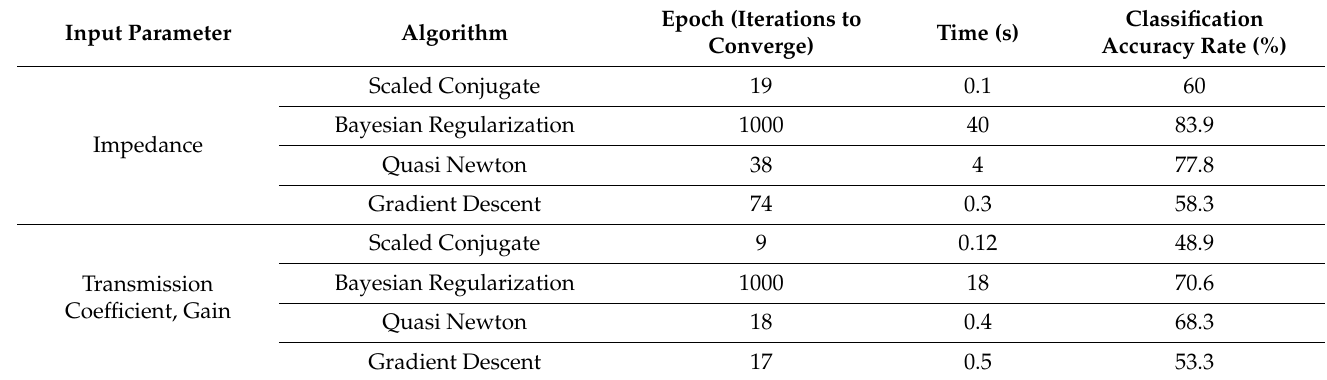
Table 5. Classification Performance between Vertical, Horizontal, and Diagonally Cracked